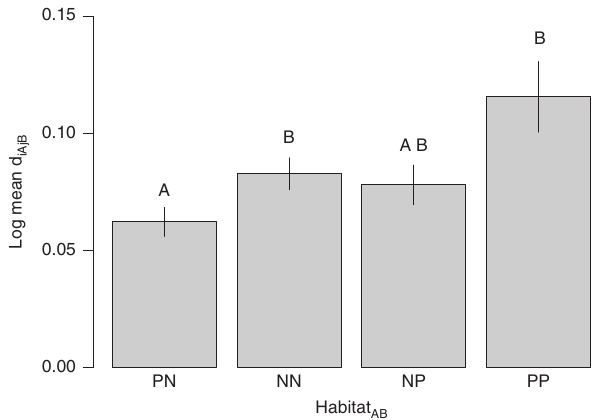
Figure 6 | Magnitude of the potential for indirect effects ( d iAjB ) among host species. N and P refer to native forest and plantation forest, respectively, such that, for example, PN refers to the situation where host i (the species that is affected) is in plantation forest and host j (the species that generated the parasitoids attacking species i ) is in native forest. The potential for hosts in plantation forest to affect hosts in native forest (NP) was not significantly greater than the potential for hosts in native forest to affect hosts in plantation forest (PN) through apparent competition (linear model: t ¼ 1.9, P ¼ 0.065). Letters above the bars are post-hoc mean comparisons. Error bars represent s.e.m. Data for this analysis were from the regional metaweb (Fig. 2), so sites were pooled, and habitat-specific species pairs were replicates (PN: n ¼ 178; NN: n ¼ 255; NP: n ¼